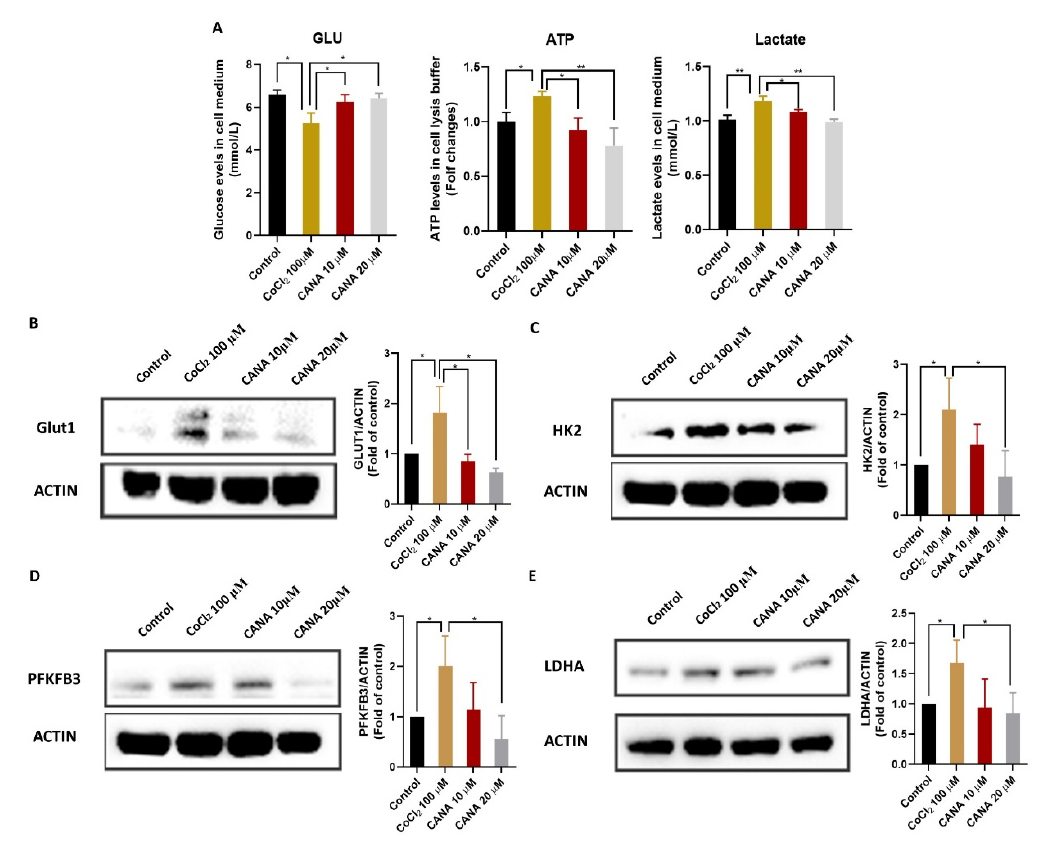
Figure 4. CANA inhibited hypoxia-induced glycolysis. ( A ) Effect of CANA or/and chemical hypoxia on extracellular glucose levels, extracellular lactate levels and extracellular ATP levels in HepG2 cells. ( B – E ) Effect of CANA or/and chemical hypoxia on protein expression of glycolytic enzymes in HepG2 cells. Data were shown as means ± S.D. ( n = 3); * p < 0.05 and ** p < 0.01. Control, normal untreated control; CANA, CANA-treated CoCl 2 (100 μ M)-induced group.